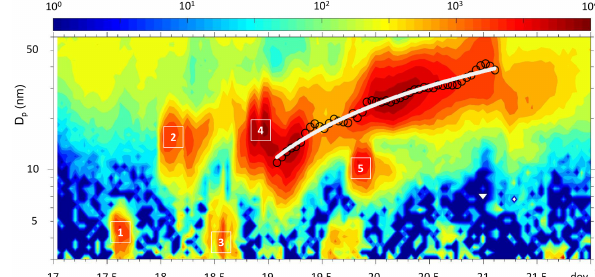
Figure 7. Time series of the particle size distribution d N / dlog D p (cm − 3 ) on a logarithmic scale (color code at the top of the con- tour plot), including the NPF event and measured with the nano- DMA 3085. Particle growth is displayed as a bold white line derived from lognormal distribution fits through size distributions measured between 19 January at 02:55 and 20 January at 24:00. The black circles represent the fitted mode mean diameters. Periods with en- hanced UCP concentrations and nucleation bursts are